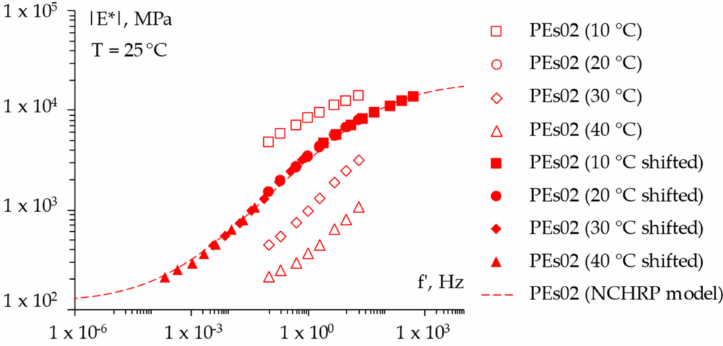
Figure 9. The frequency sweep results (master curve) of the PEs02